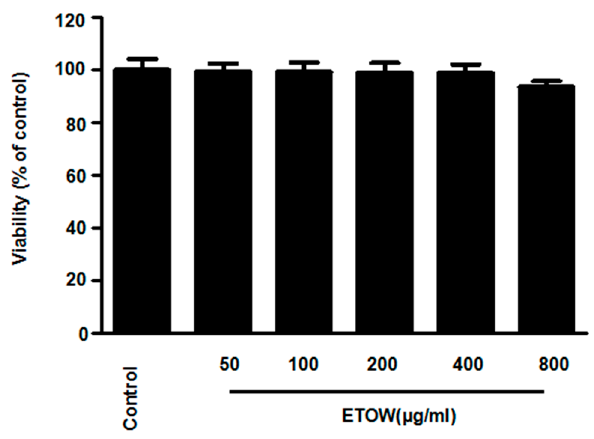
Figure 1. Effects of ETOW on cell viability in HT22 cells. HT22 cells were incubated for 12 h with various concentrations (50, 100, 200, 400, 800 μ g/mL) of ETOW. Cell viability was determined by MTT. Each bar represents the mean ± SD ( n = 3). ETOW, ethanol extracts of Taraxacum officinale Wigg.